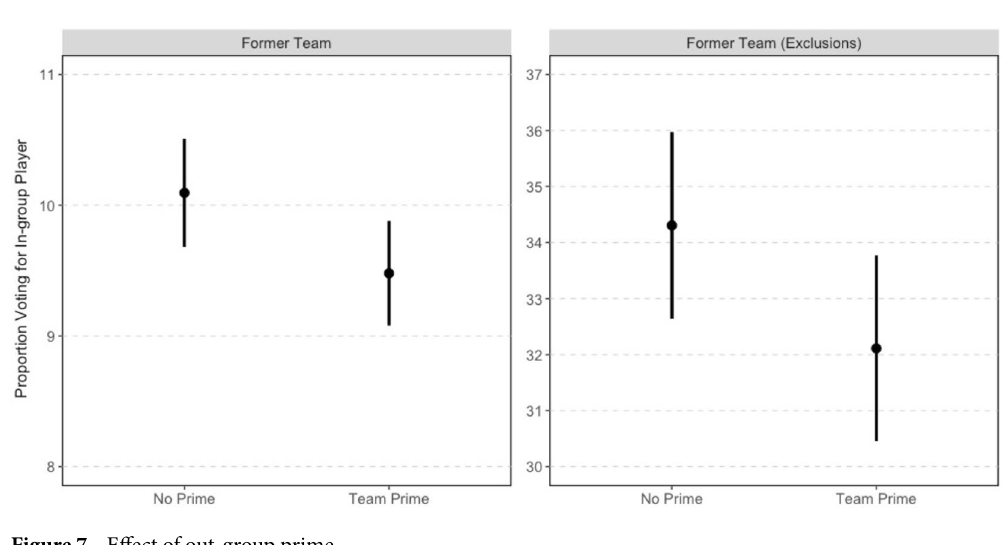
Figure 7. Effect of out-group